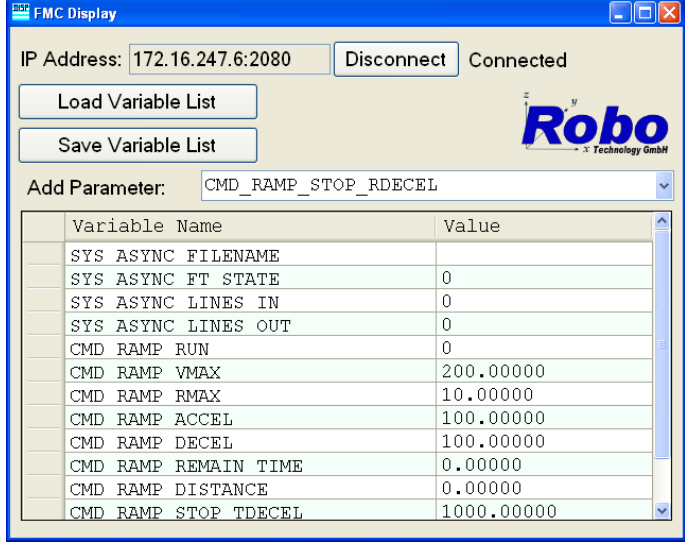
Figure 12: FMC Display - Numerical values of facility and robot